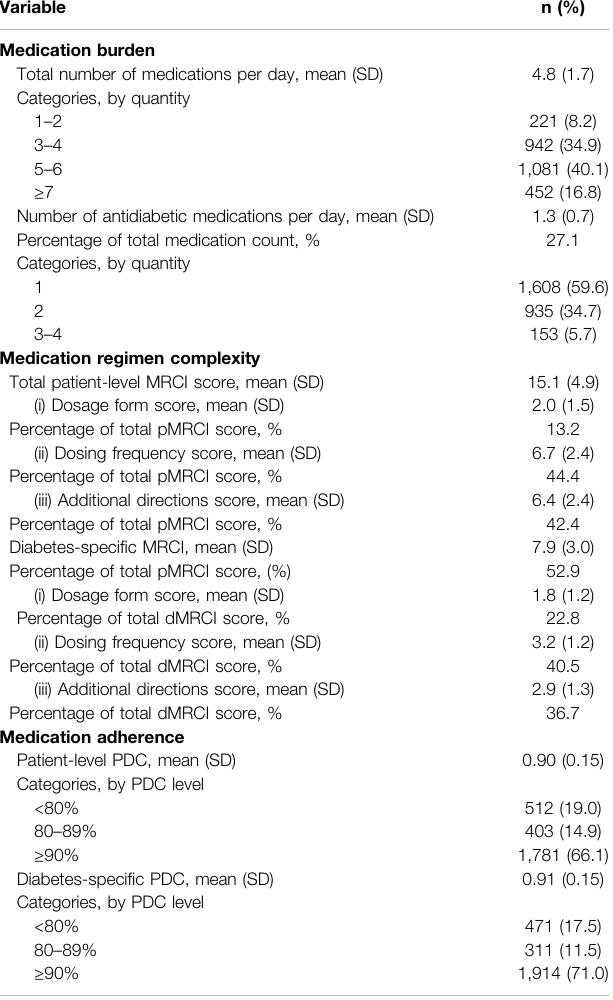
TABLE 2 | Treatment characteristics of study cohort from “ EnPHC-Eva: Facility ” Malaysia, 2018-2019 (N = 2,696).